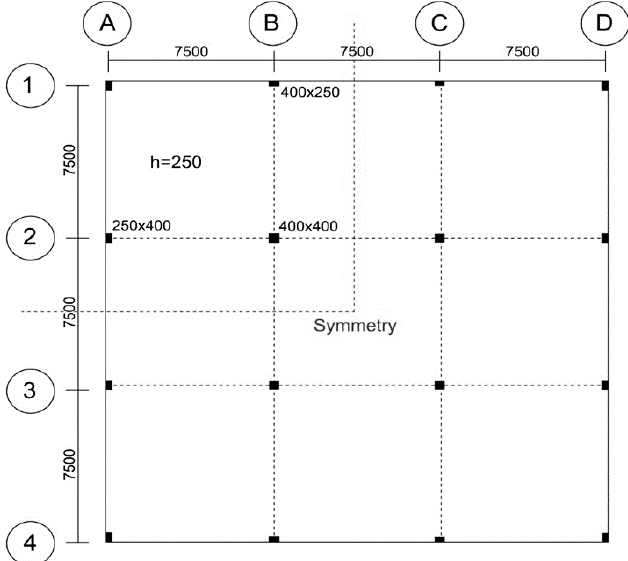
Figure 1. Plan view of the considered flat slab (Dimensions in